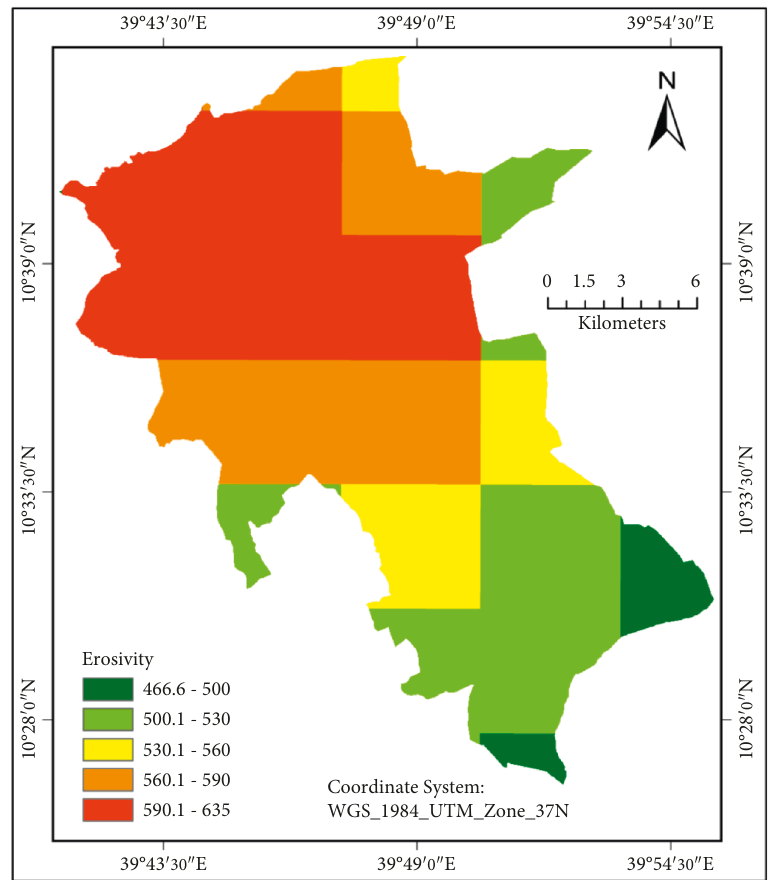
Figure 3: Erosivity map (R-factor map).